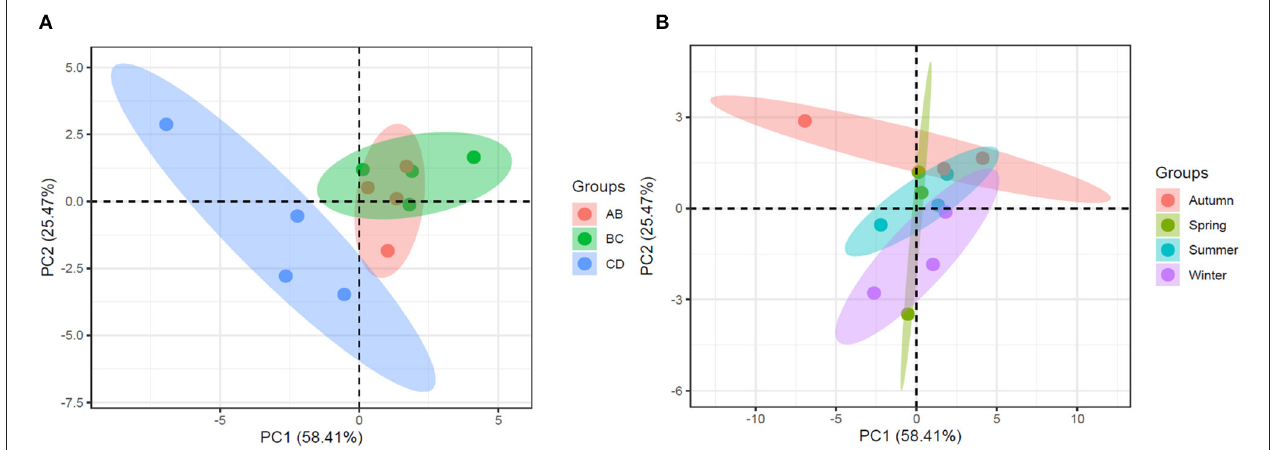
FIGURE 4 | The projection of (A) reach and (B) seasonal observations on principal component 1 and principal component